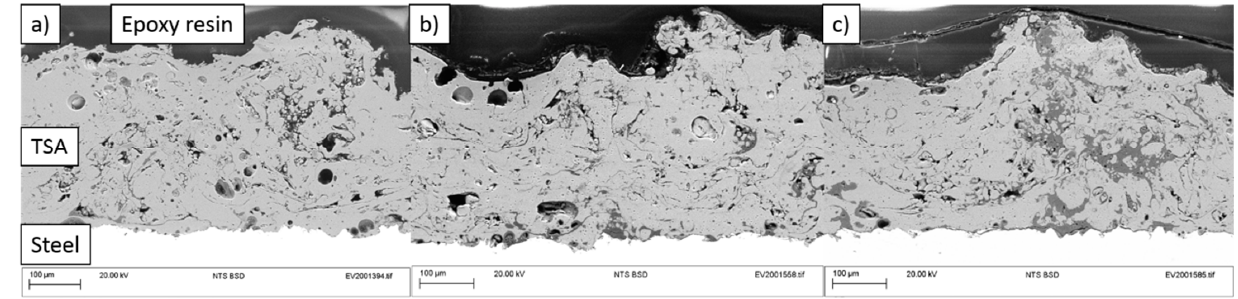
Figure 13. Cross-sectional SEM images of TSA1050 samples immersed at El Bocal (Santander, Spain) for 6 months in ( a ) atmospheric/splash, ( b ) tidal and ( c ) immersed conditions.